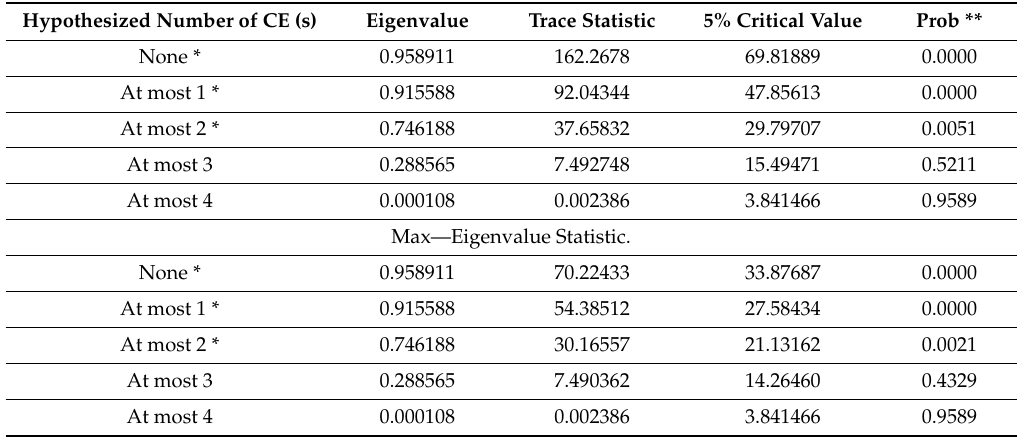
Table 6. Johansen co-integration test results using trace indicator and maximum eigenvalue trace